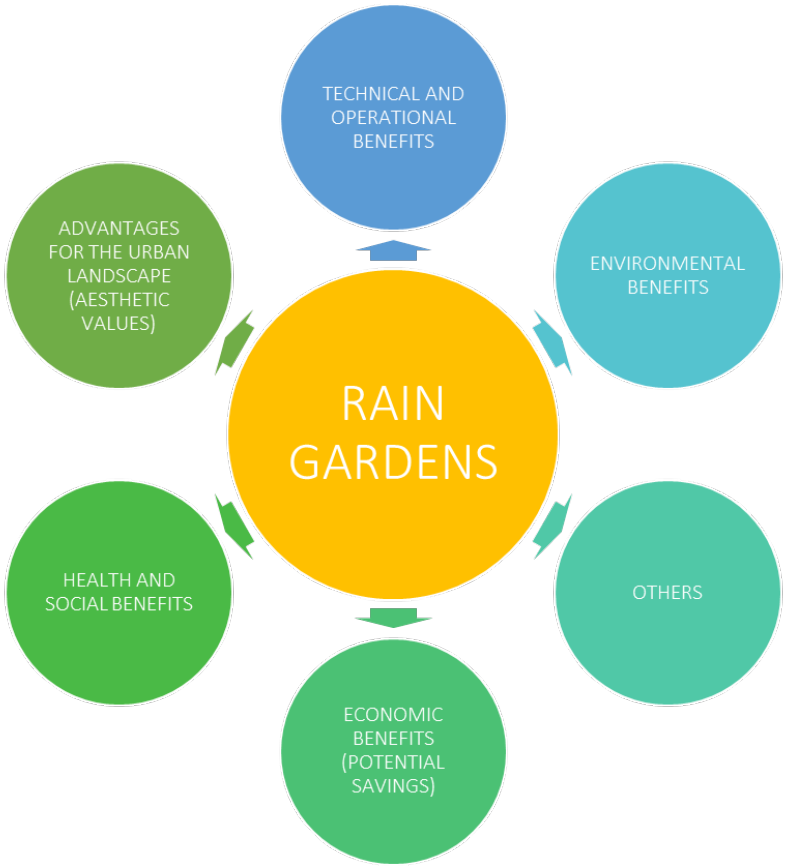
Figure 1. Holistic approach to the advantages of using rain gardens in an urban space — the main types of benefits.